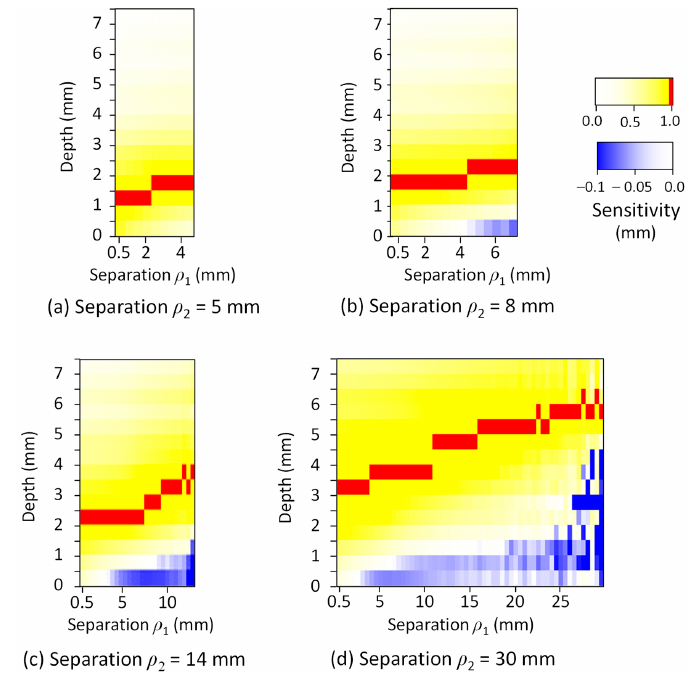
Figure 4. The mapping result of the normalized sensitivity–depth curve in the skin-subcutaneous tissue model. The source–detector separation (far position) ρ 2 was changed to ( a ) 5 mm, ( b ) 8 mm, ( c ) 14 mm, and ( d ) 30 mm. Sensors 2021 , 21 , x FOR PEER REVIEW